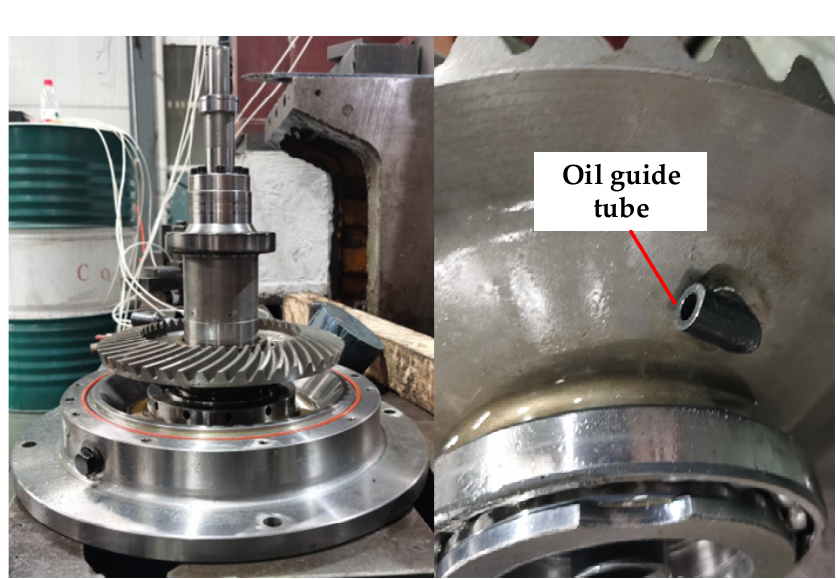
Figure 5. Internal layout of the test gearbox.